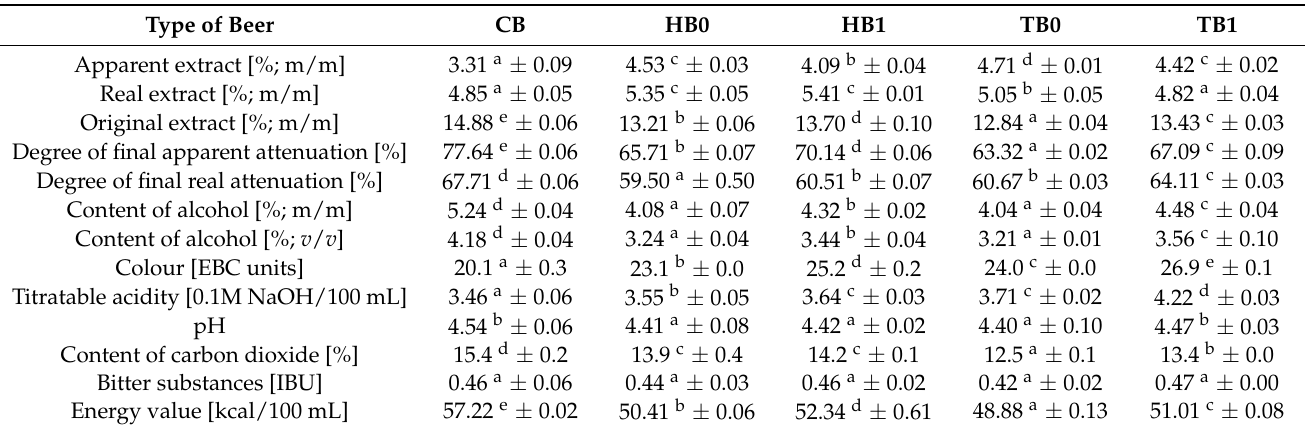
Table 1. Physicochemical analysis of the beers produced with an addition of the Saskatoon berry